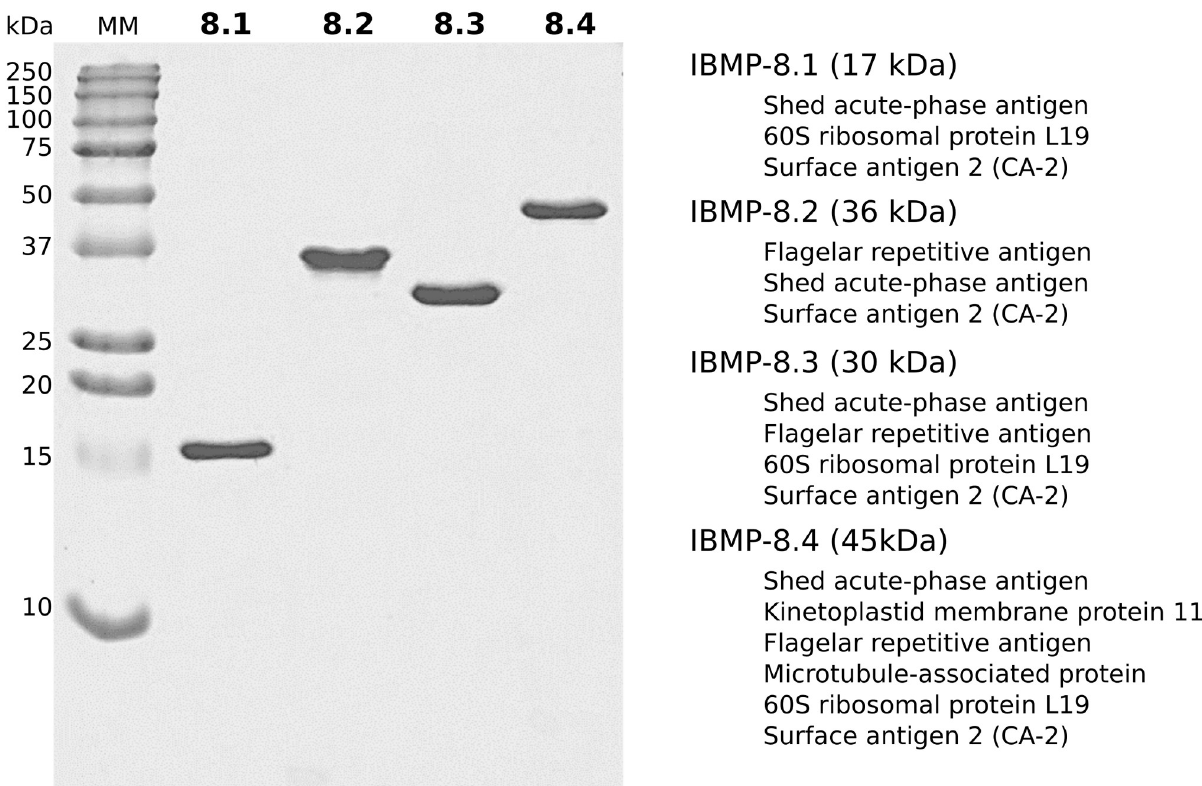
Fig 1. SDS-PAGE stained with Coomassie brilliant showing the chimeric purified antigens. The T . cruzi proteins whose antigenic regions were used to construct the chimeric antigens are described on the right. Lanes 8.1 to 8.4 indicate the IBMP multi-epitope antigens (1 μ g of each antigen was loaded per lane). MM: molecular weight